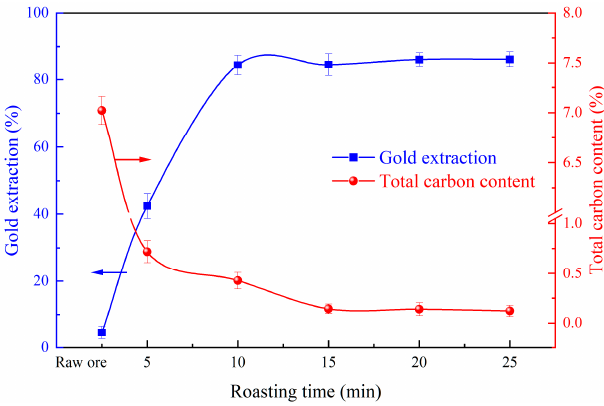
Figure 8. The effect of roasting time on gold extraction.